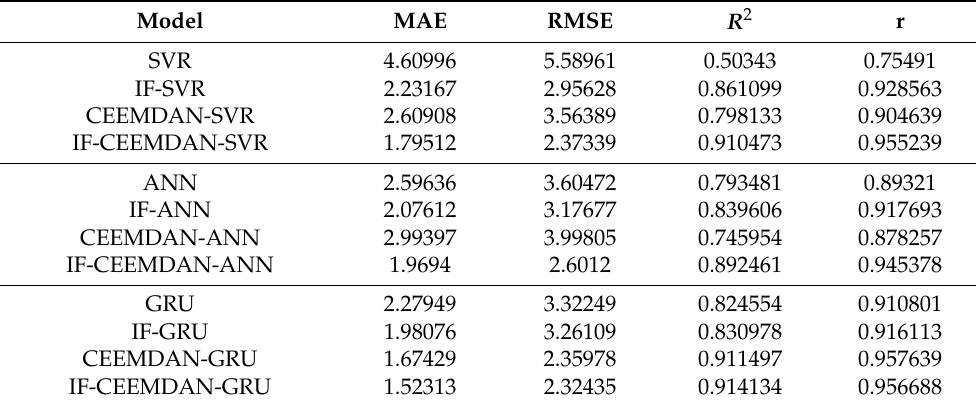
Table 1. Performance results of different models for testing